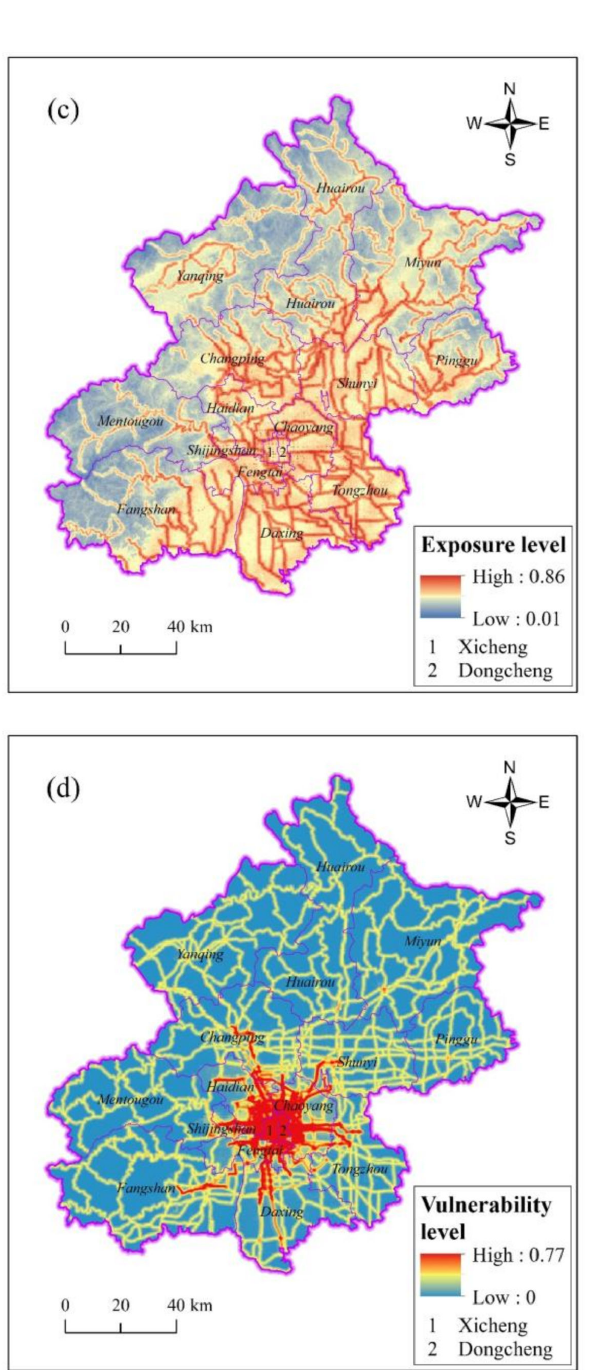
Figure 11. Level maps of hazard ( a , b ), exposure ( c ), and vulnerability ( d ) in Beijing. ( a , b ) denote the hazard levels ignoring and considering the land subsidence,